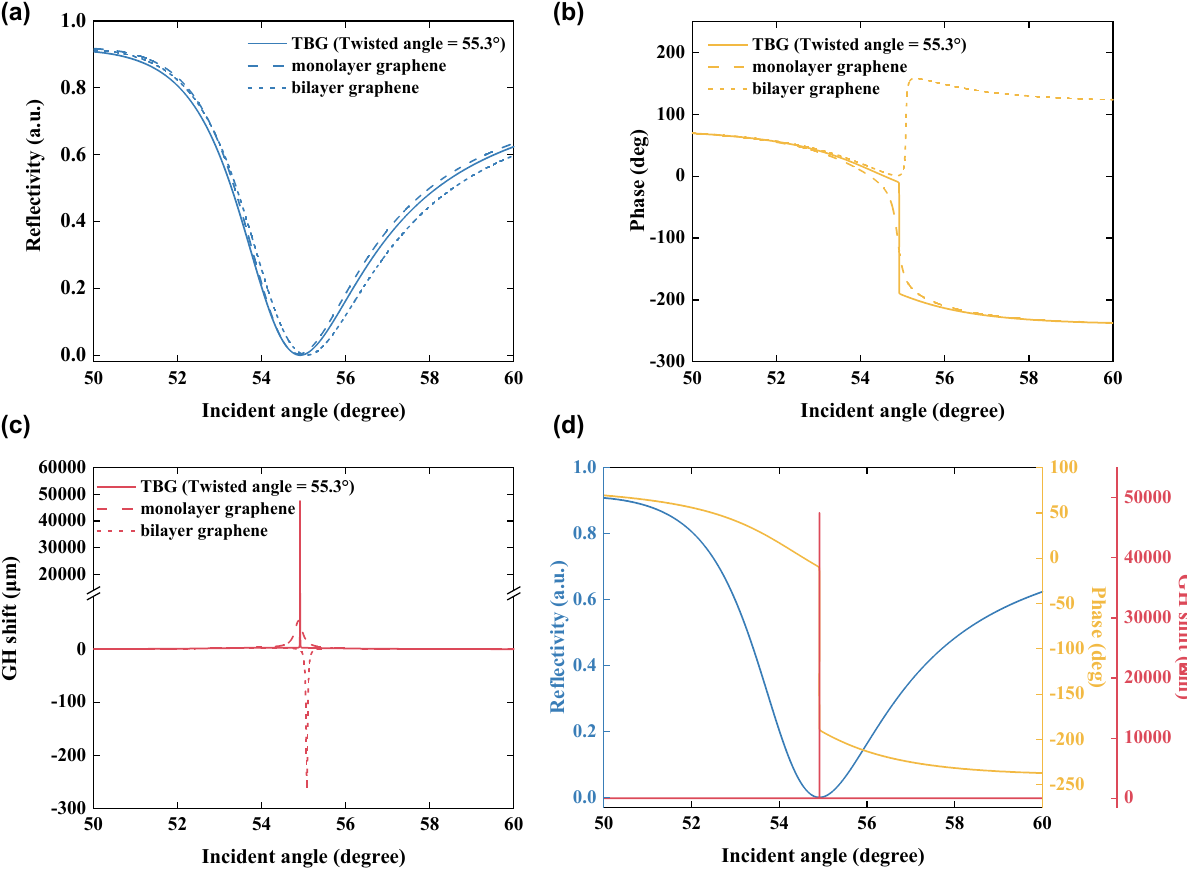
Figure 2: Minimum reflectivity (a), phase (b) and GH shift (c) based on plasmonic Au film-monolayer graphene (dash line), Au film-bilayer graphene without any twisting (short dash line), and Au film-1-TBG superlattice with a twisted angle of 55.3 ◦ (solid line). (d) Comparison of minimum reflectivity (blue), phase (orange) and GH shift (red) extracted from Au film-1-TBG with a twisted angle of 55.3 ◦ . Noting that, the thickness of Au film is 44 nm, and the excitation wavelength is 632.8 nm. The running buffers were HEPES, and PBS solutions.